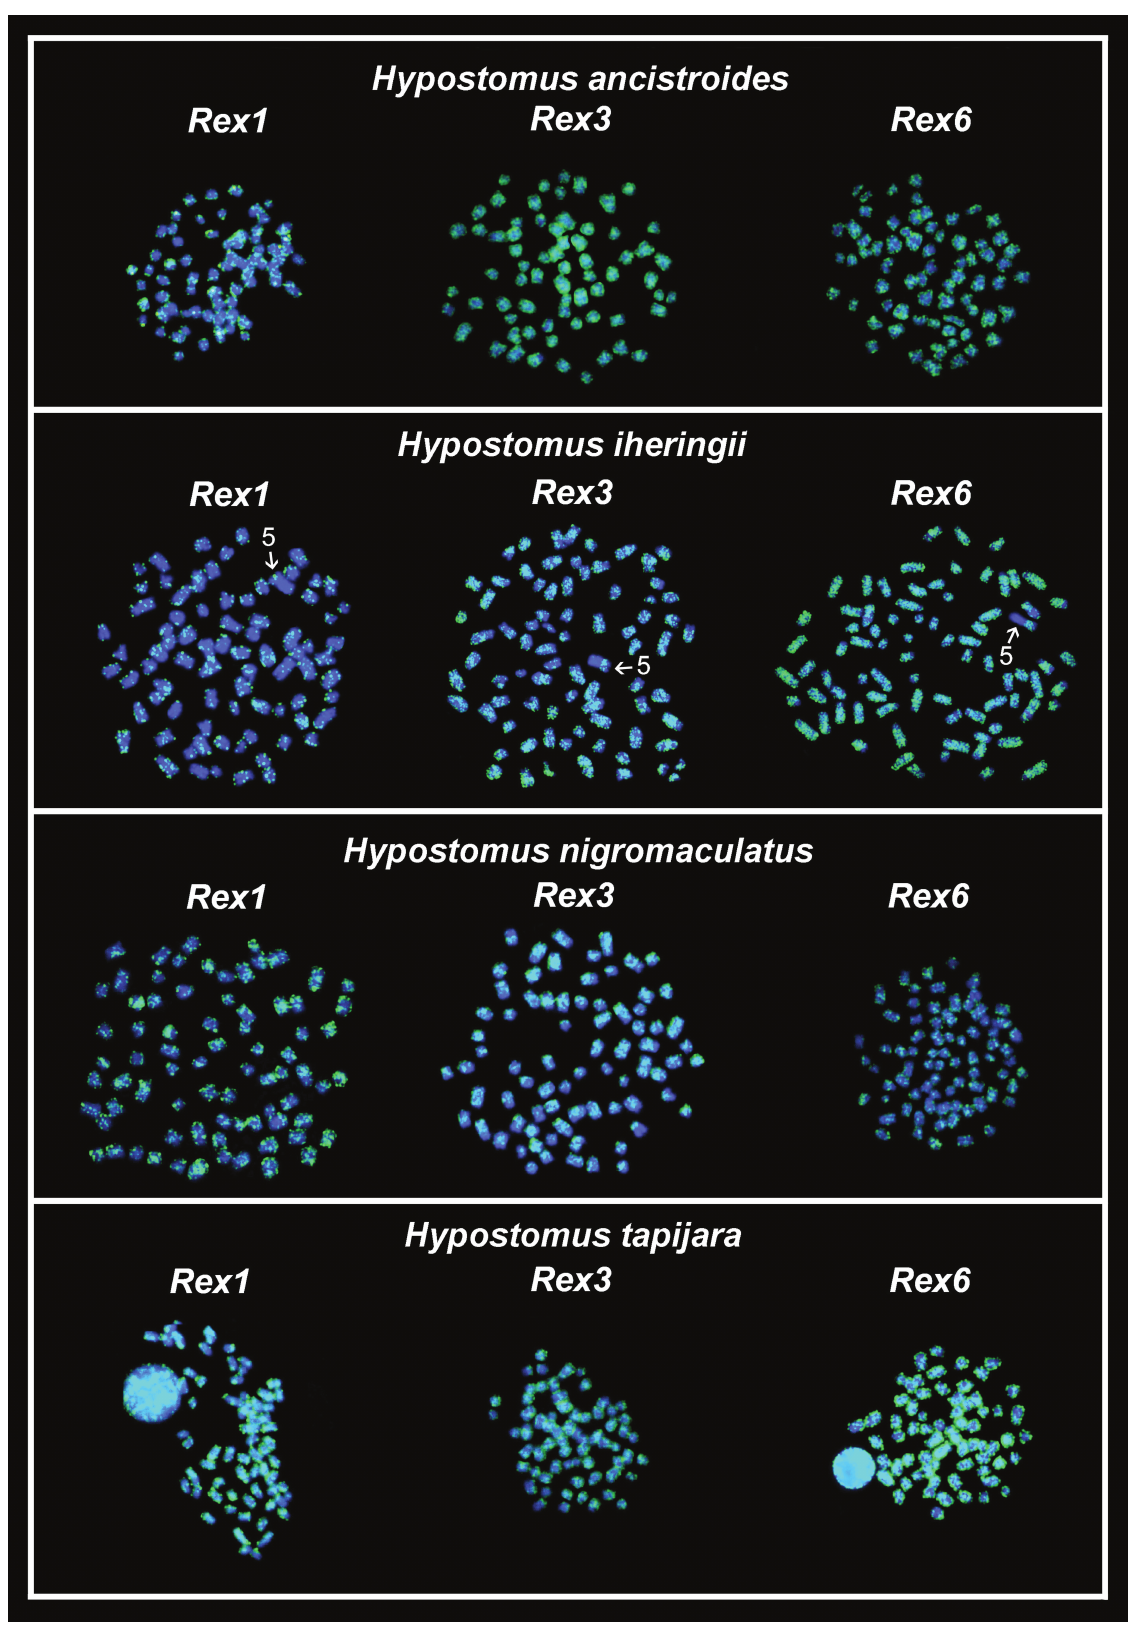
Fig. 3. Metaphases of the Hypostomus species submitted to FISH with probes of the Rex elements. The numbers indicate chromosomal pairs in highlighted. Bar = 10